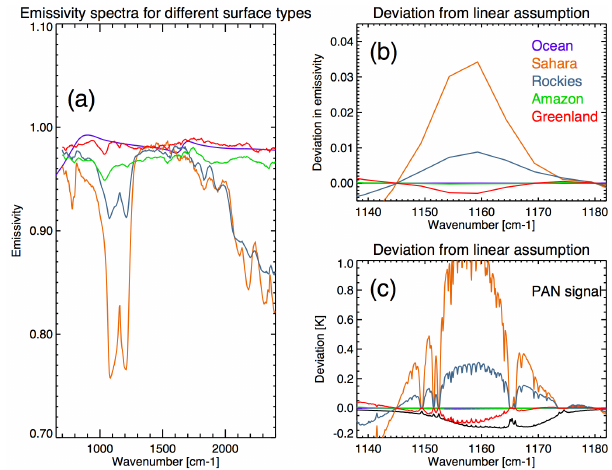
Figure 8. (a) Emissivity spectra for different surface types, taken from the UW/CIMSS HSR emissivity database. (b) Deviation of the emissivity spectra from a linear extrapolation between 1145 and 1180cm − 1 . (c) Error in clear-sky brightness temperature re- sulting from the deviation of emissivity from the linear assumption. The black line in (c) represents the PAN signal associated with the July extratropical “maximum-aloft” profile shown in Fig. 4e and is shown for the purpose of illustrating the spectral shape of the PAN feature relative to the spectral shape of the signal associated with deviation from linear surface